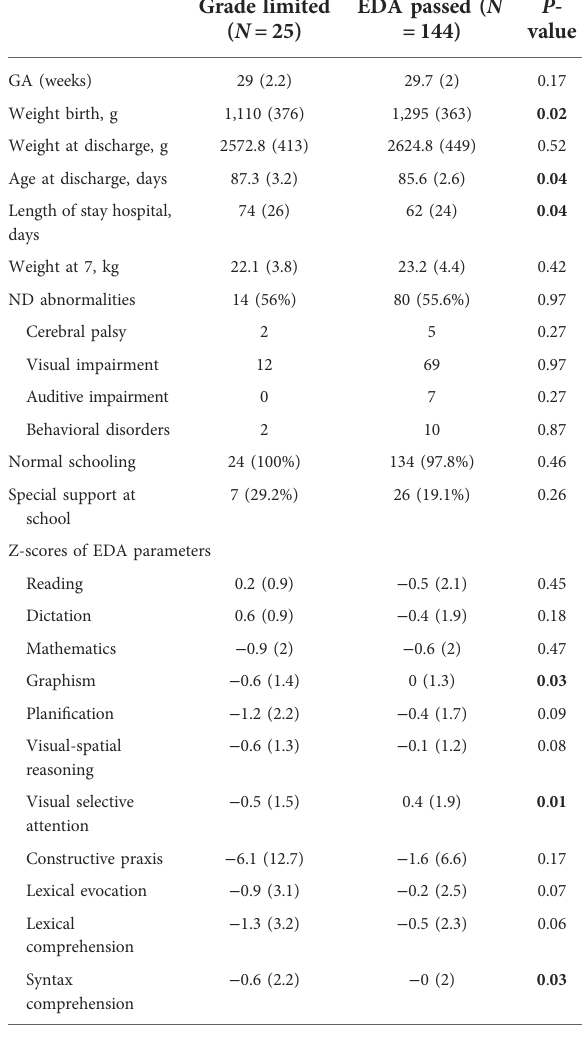
TABLE 4 Characteristics of children who did or did not pass the